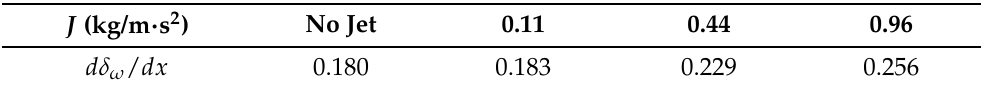
Table 2. Growth rate of the cavity separated shear layer for Re D ≈ 50,000; sharp edge at LE; different J .